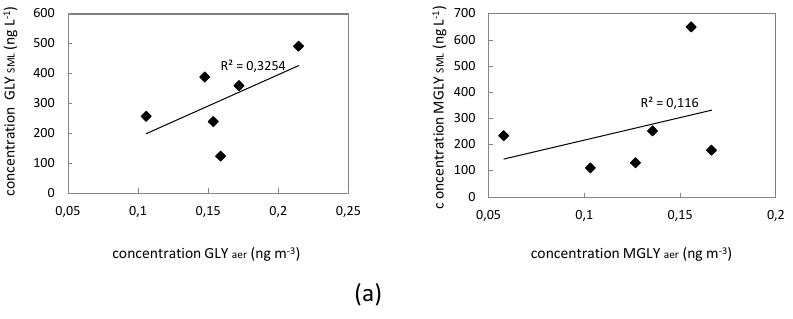
Fig. 6. Correlation of (a) GLY and (b) MGLY in SML and in aerosol